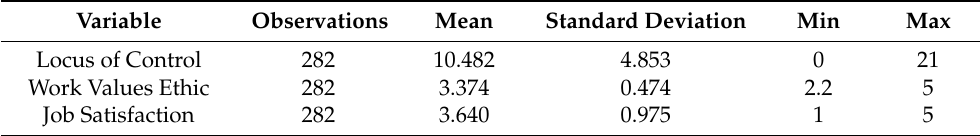
Table 1. Descriptive analysis of locus of control, work values ethics and job satisfaction.